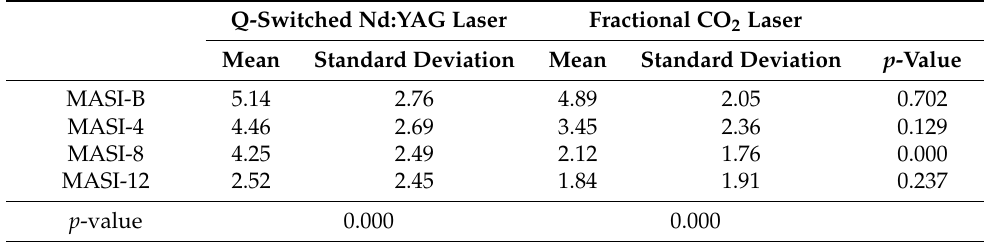
Table 3. Mean and standard deviation of the MASI score in both groups over time.